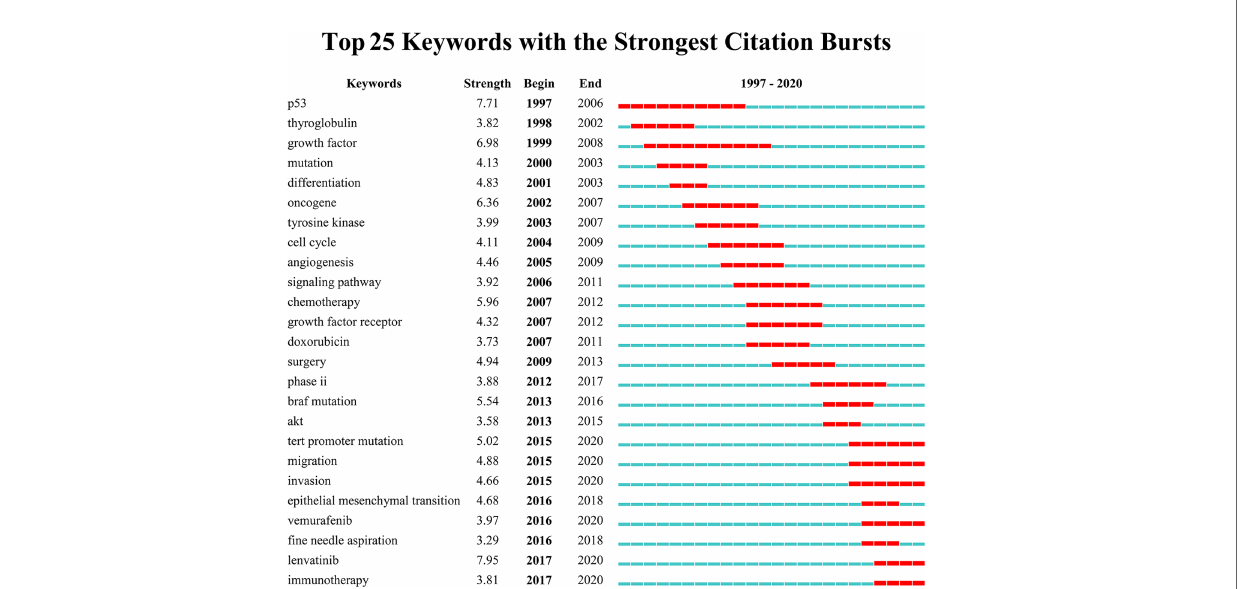
FIGURE 8 | Top 25 keywords with the strongest citation bursts. Keywords with the strongest citation bursts in the scienti fi c literature were analyzed and visualized in the keyword ’ s bursts map. Each short line represented a year and lines in red stood for the burst detection years. Keywords with red lines extending to the latest year can indicate the research frontiers in a short period of time in the